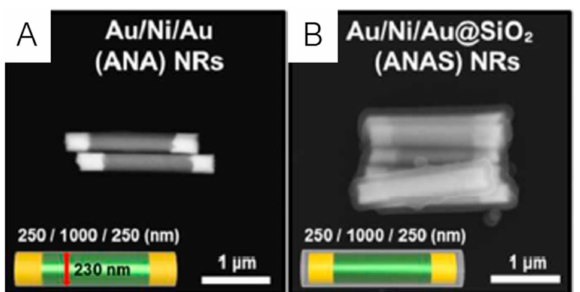
Figure 7. FE-SEM images of Au / Ni / Au nanorods ( A ) and silica-coated Au / Ni / Au nanorods ( B ) and respective schematic representations. Adapted from [65] with permission from Royal Society of Chemistry, 2020.